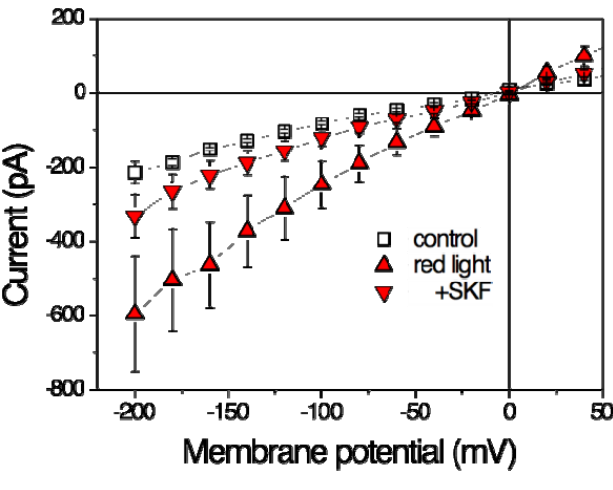
Figure 2. Effects of red laser light on steady-state current-voltage curves in HMC-1 cells (Human Mast Cell line). Whole-cell patch-clamp recording. Open squares represent data in the absence of irradiation (control), filled symbols at the end of a 20-min-lasting irradiation period of 640 nm (48 mW, ~500 mW/cm 2 ) in the absence (triangles up, red light) and presence of five measurements ± SEM. (Based on data from Zhang et al. 2012